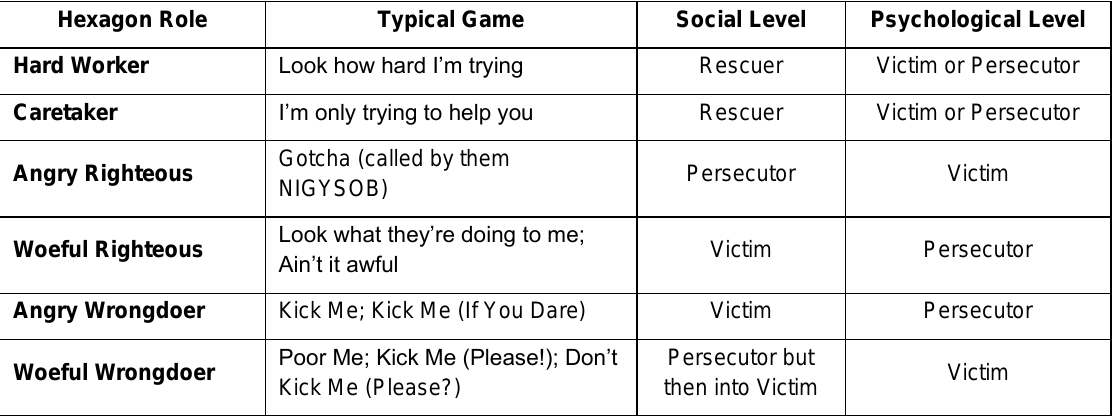
Table 1: Summary of Roles (based on Schiff & Contributors,